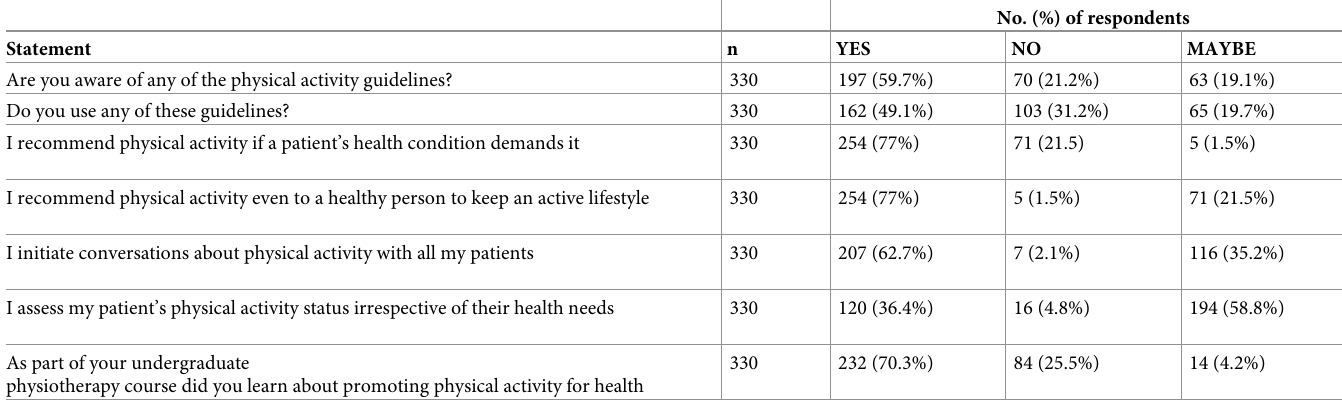
Table 3. Knowledge and current practice statements of